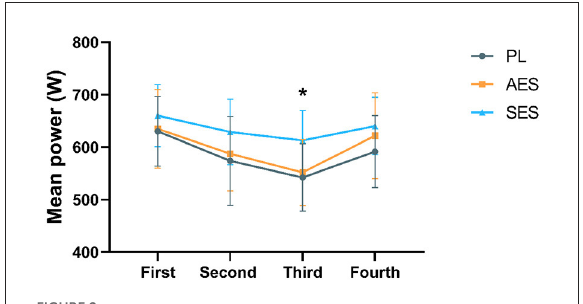
FIGURE2 Mean power results of each WAT. * Indicates a significant difference between the serial enteric-coated group and the placebo group ( p < 0.05).